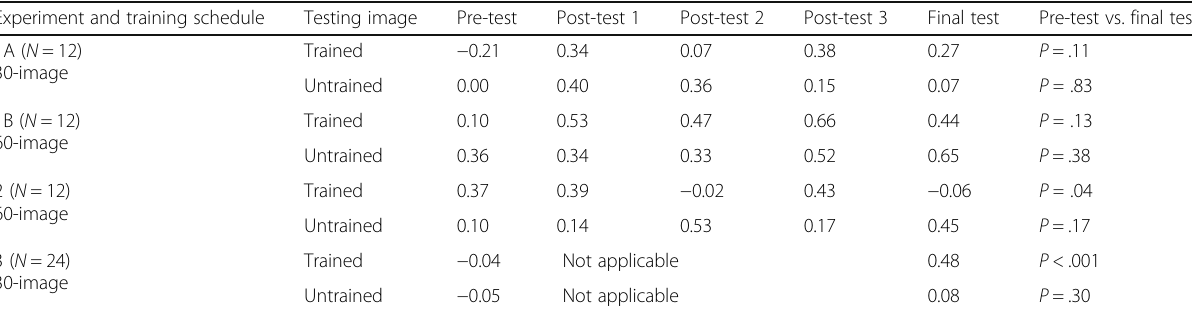
Table 3 Mean d ’ for the small tumor cutout used in the testing sessions Experiment and training schedule